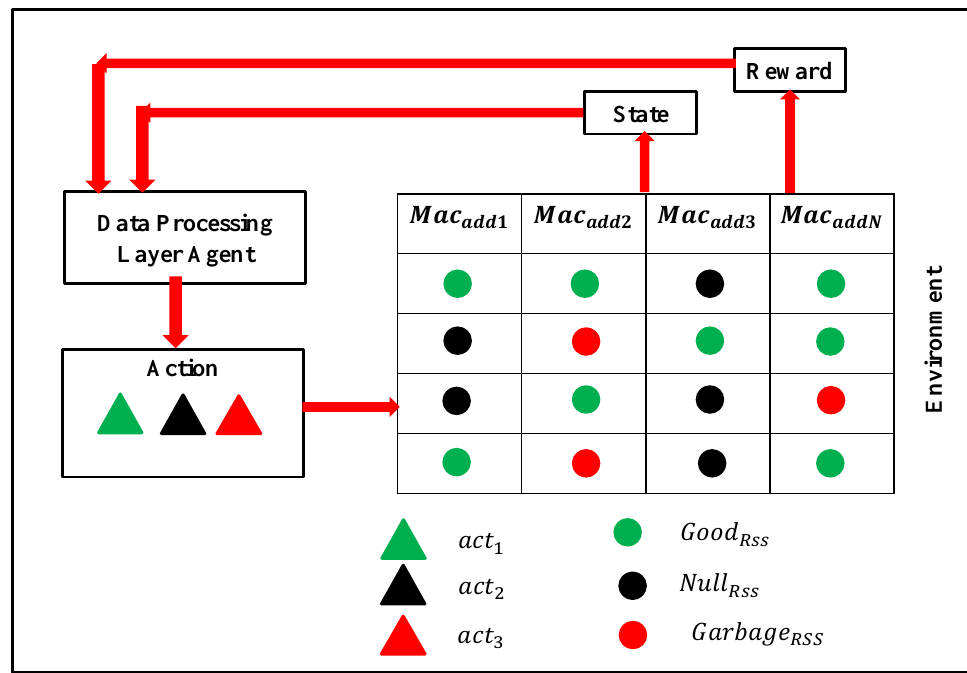
Figure 1. Deep reinforcement learning agent for tracking missing and garbage